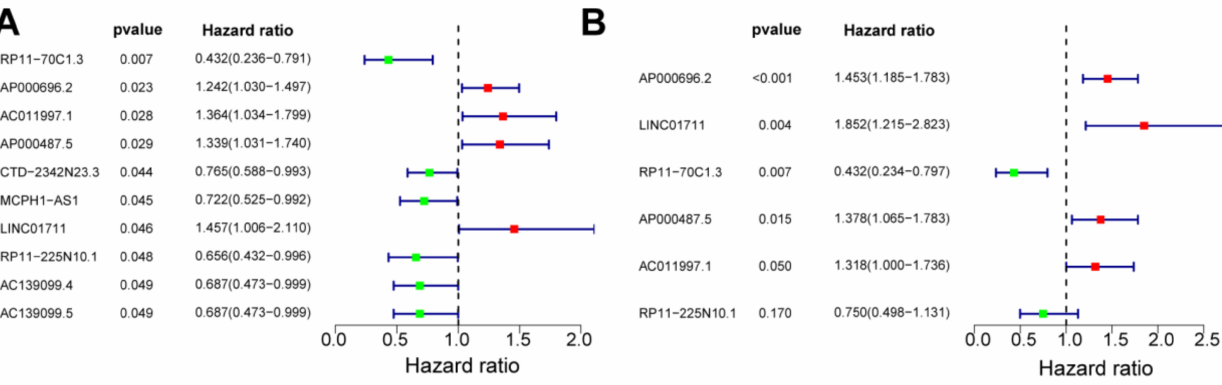
Figure 3. Forest map of univariate Cox regression analysis ( A ) and multivariate Cox regression analysis ( B ) for